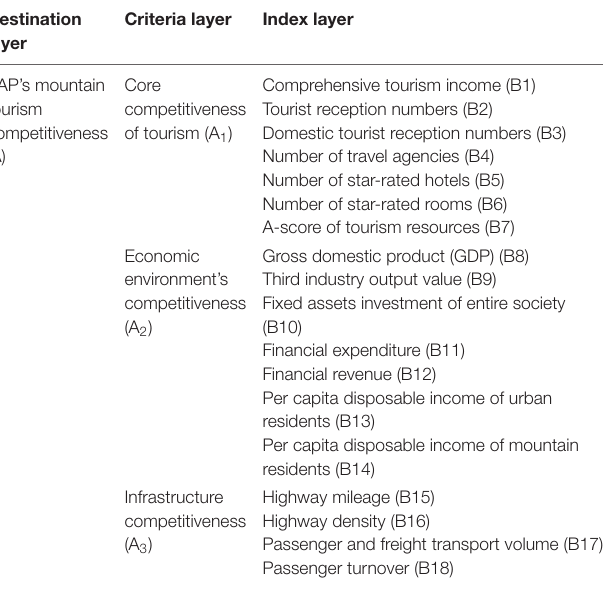
TABLE 1 | Evaluation index system of EAP mountain tourism